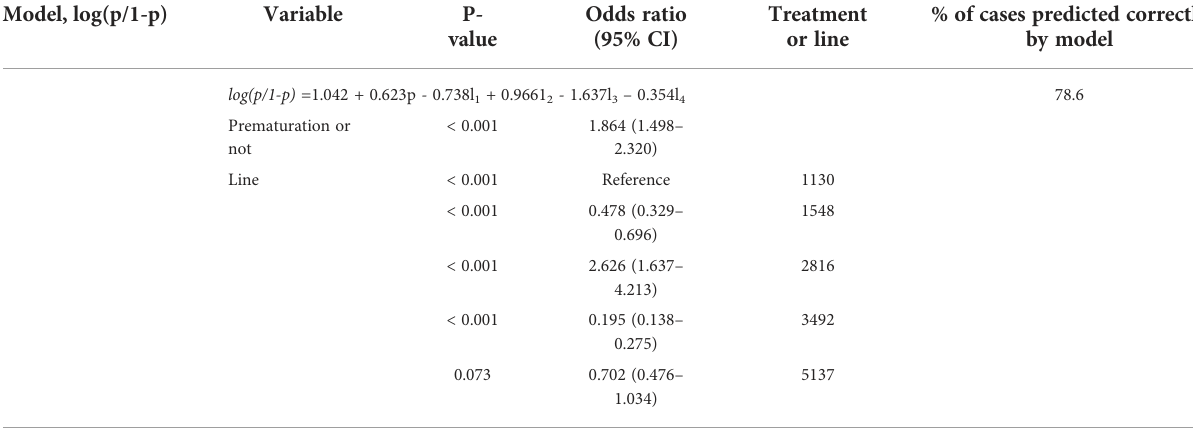
TABLE 3 Logistic regression model of greenhouse survival after 41 days in Trial I. Model,